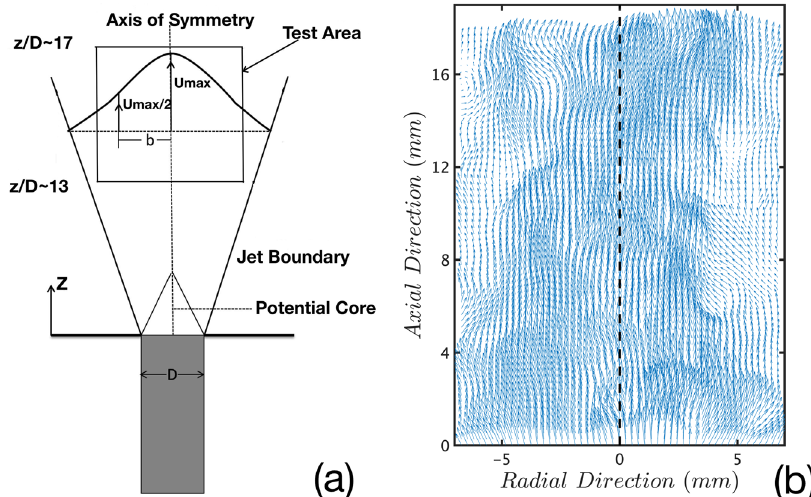
Fig. 1 Experimental setup and fl ow fi elds. a Axisymmetric jet fl ow about the symmetry axis z is generated by N 2 gas ejected from cylinder of radius D = 4.7 mm. Flow velocity in a plane normal to the symmetry axis peaks on the axis and is denoted U max . Rectangular axial region of size 13.4 × 17.7 mm where velocity measurements were made was approximately 13 D downstream (i.e., z -direction) of inlet. b Snapshot of velocity fi eld for fl ow of Re ≈